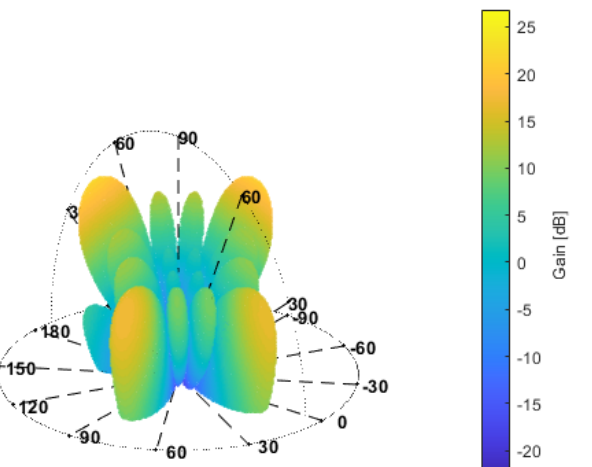
Figure 8. Beam pattern of the LOFAR tile with the beam steered at φ til = 8 ◦ and θ til = 20 ◦ .